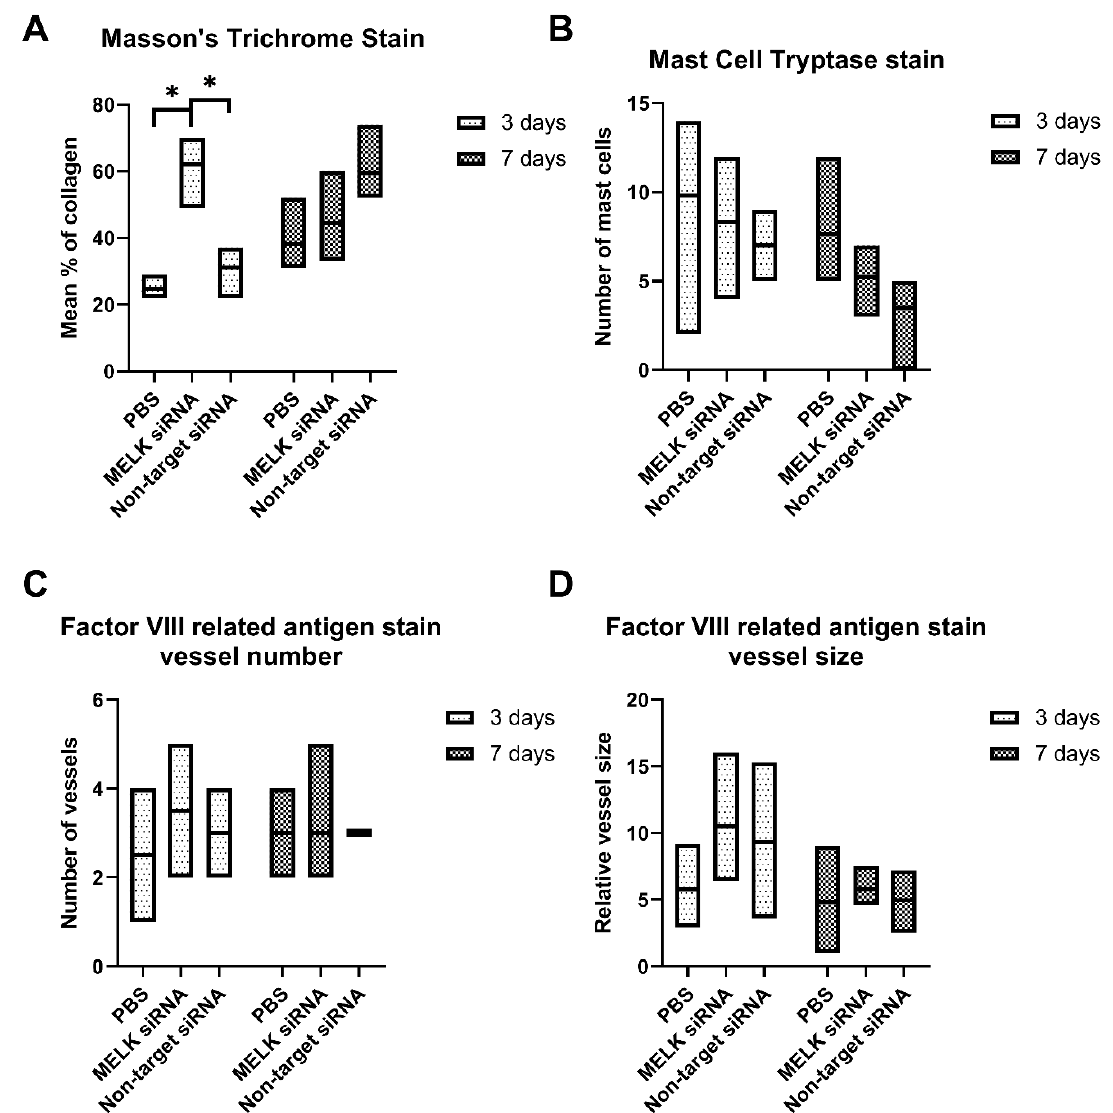
Figure 4. Immunohistochemistry staining results of wounds, 3 and 5 days after treatment with PBS, MELK siRNA, and non-target. ( A ) % of total collagen measured by Masson’s Trichrome Stain. ( B ) the number of mast cells measured by Mast Cell Tryptase stain. ( C ) Number of blood vessels measured by Factor-VIII-related antigen stain. ( D ) Relative vessel size measured by Factor-VIII-related antigen stain. n = 6. Results are presented as the mean ± range. * — p < 0.05